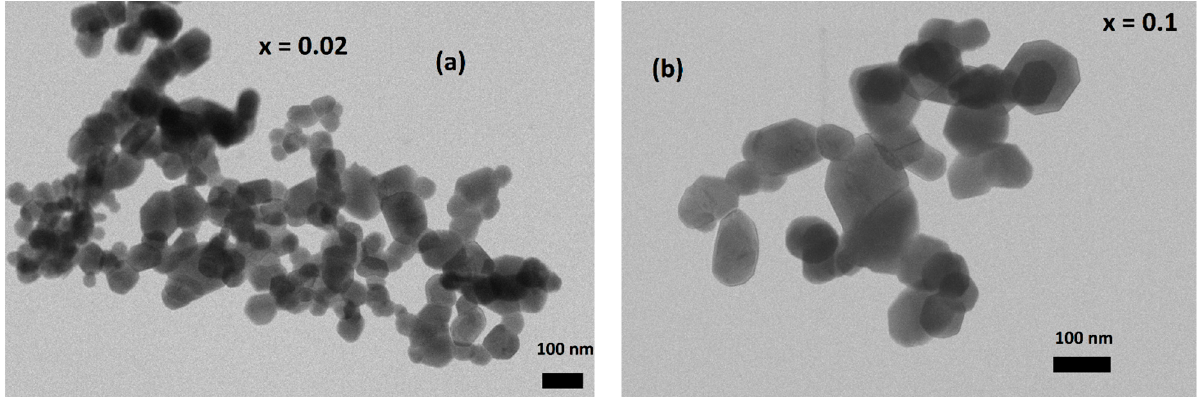
Figure 4. Selected TEM pictures for Pr 0.7 Sr 0.3-x Ca x MnO 3 nano-sized samples for x = 0.02 ( a ), x = 0.01 ( b ).